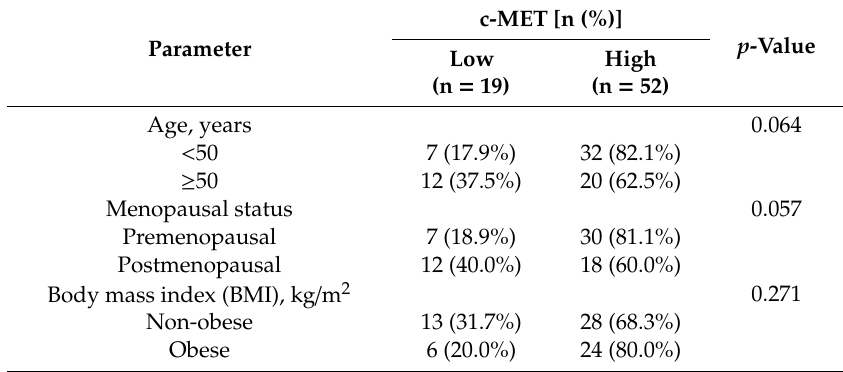
Table 3. Expression of c-MET and its association with clinicopathologic parameters in breast cancer patients (n =